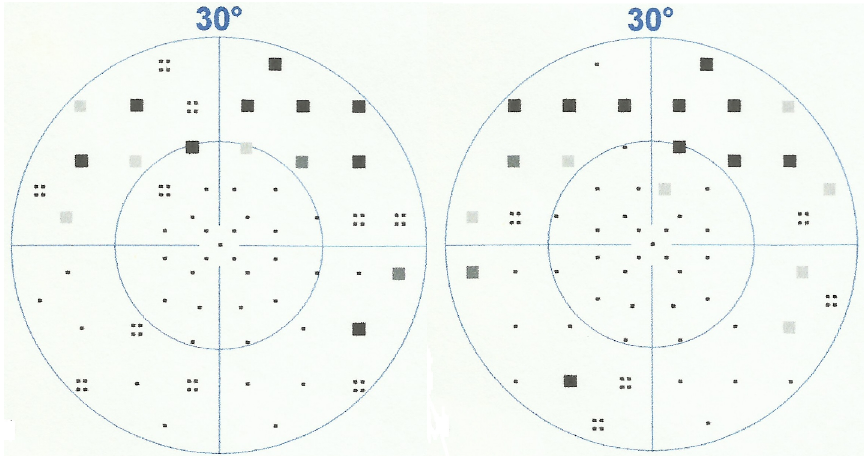
Figure 2: Pattern deviation probability maps showing superior visual field constriction in both eyes On fluorescein angiography, the patches appeared as hypofluorescent areas with faintly hyperfluorescent bor- ders. Choroidal vessels were prominent within the